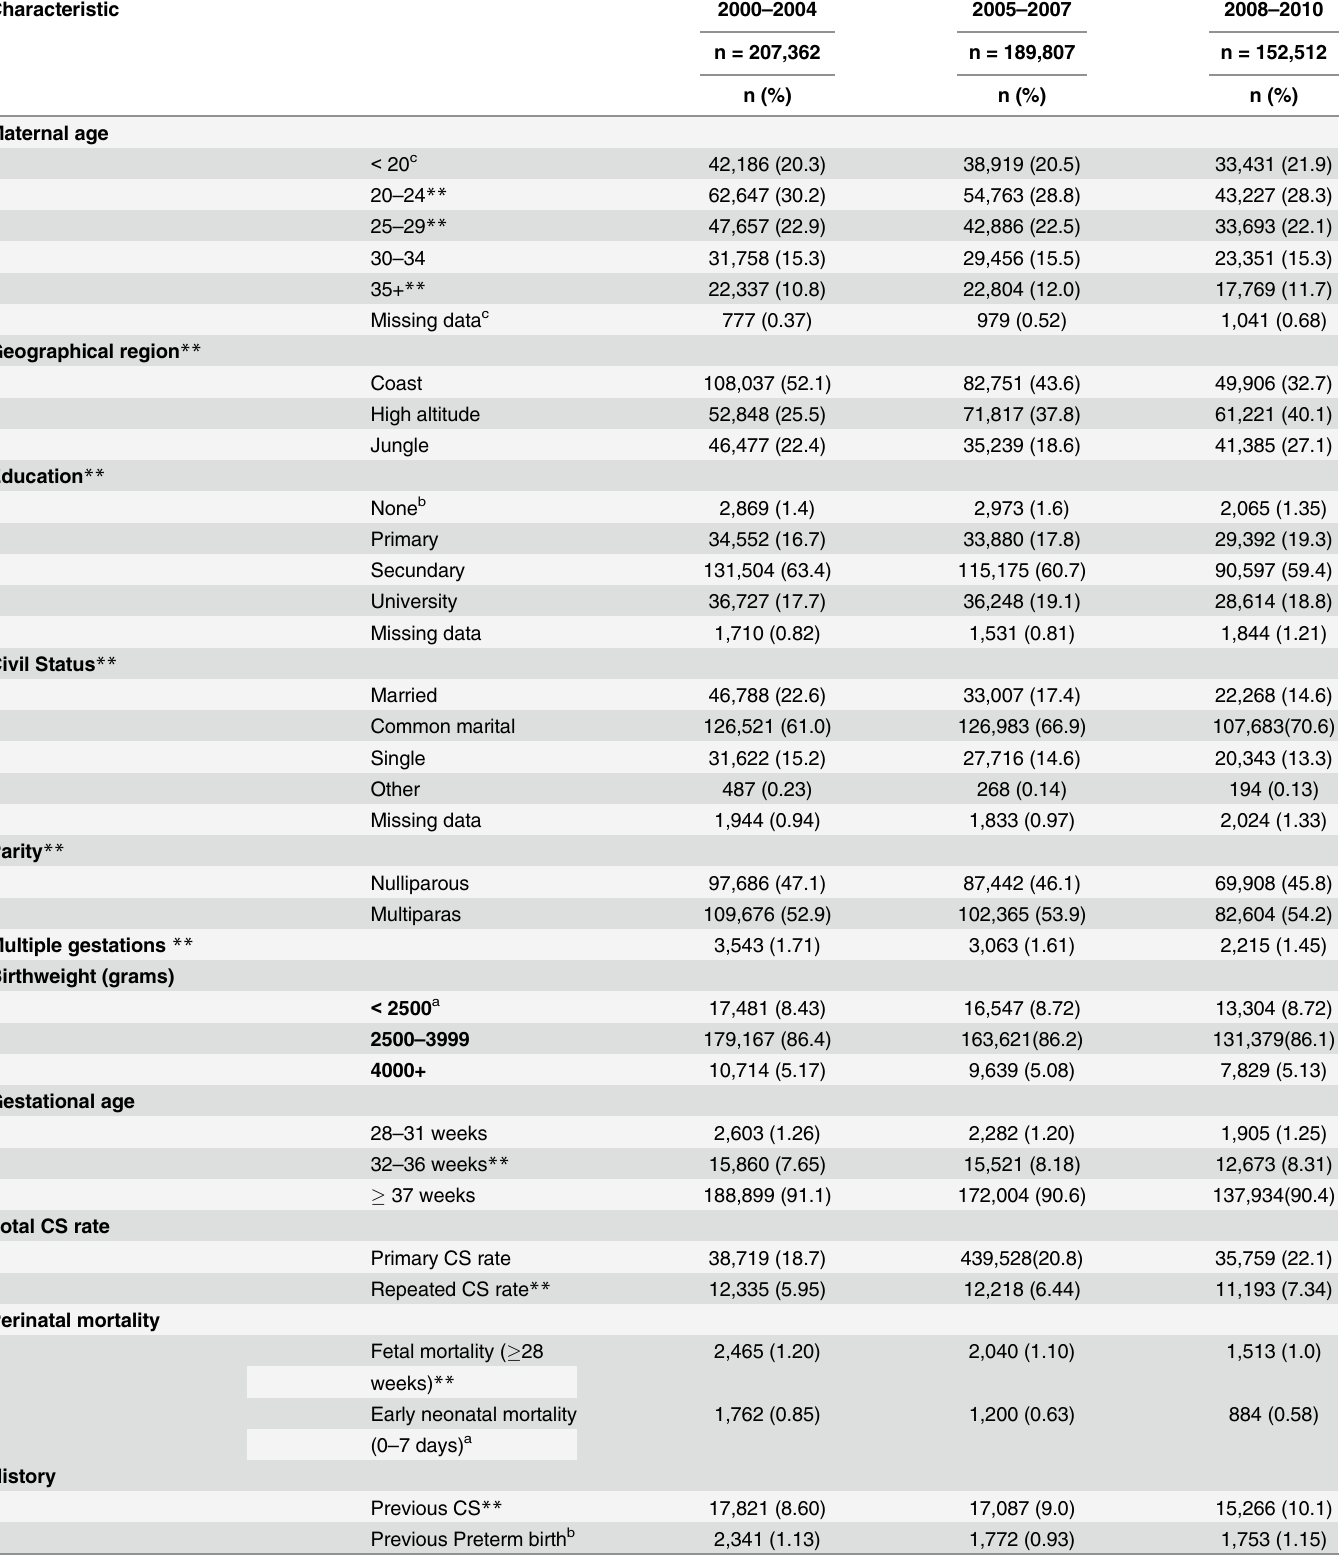
Table 2. Characteristics of obstetric population (including all births, singleton and multiple, from 28+0 to 44+6 gestational weeks), 2000 – 2010, years stratified.